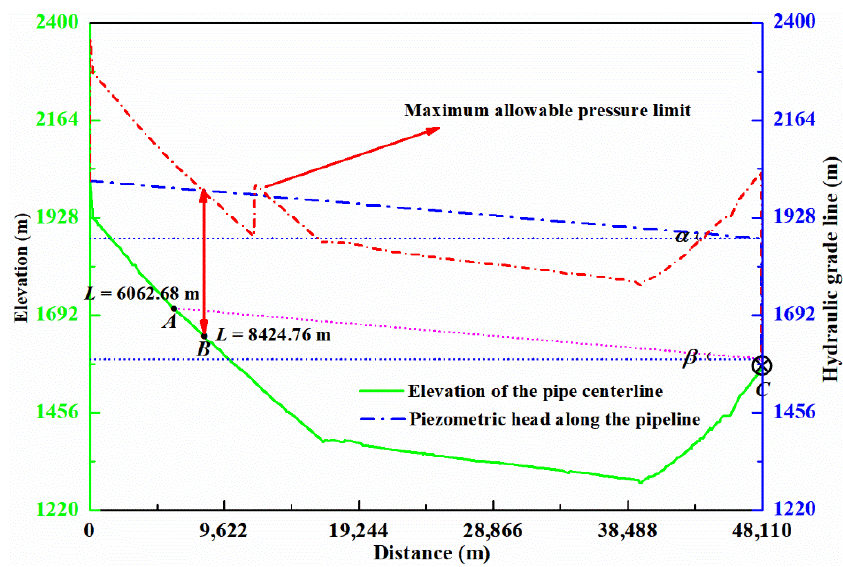
Figure 4. A LHGWSS of a practical project.